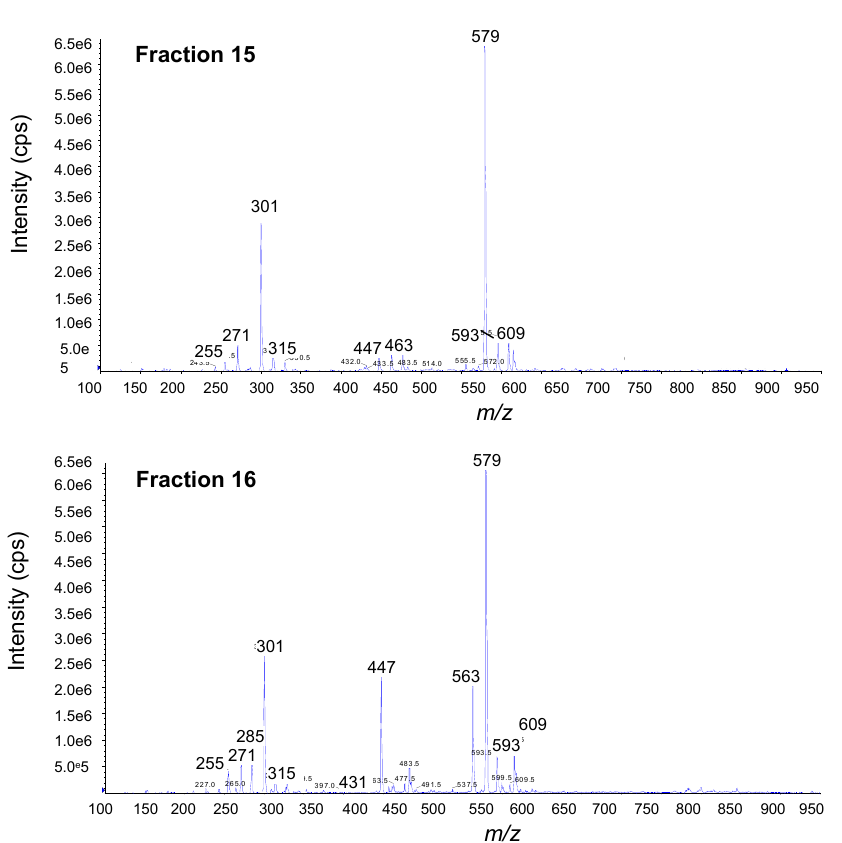
Figure 4. Full scan mass spectrum of fractions 15 and 16 recorded with ESI in negative ionization